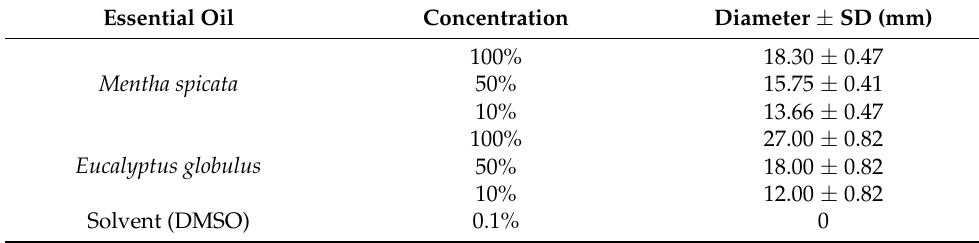
Table 3. Inhibitory activity of the essential oils of M. spicata and E. globulus